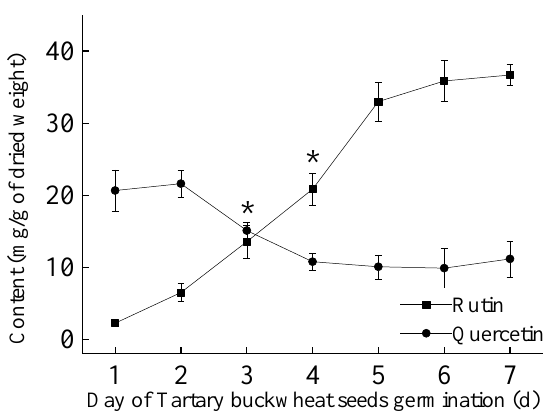
Figure 2. Changes in rutin and quercetin contents during tartary buckwheat germination. During the germination process, the content of rutin was significantly increased, and the content of quercetin was relatively stable. Values were expressed as the mean ± SD from triplicate experiment. One-way ANOVA with LSD was used to determine significant differences over time. *, p < 0.05.